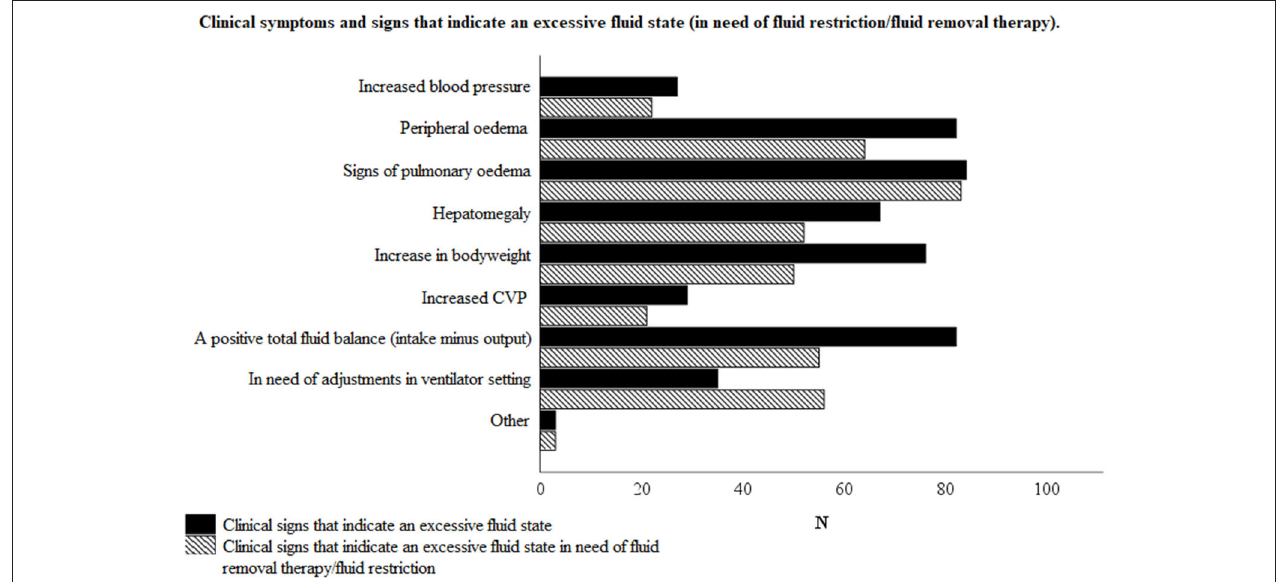
FIGURE 3 | Clinical symptoms and signs that indicate an excessive fluid state with or without the need of fluid removal therapy and/or fluid restriction, according to the respondents. Total number of respondents N = 82.